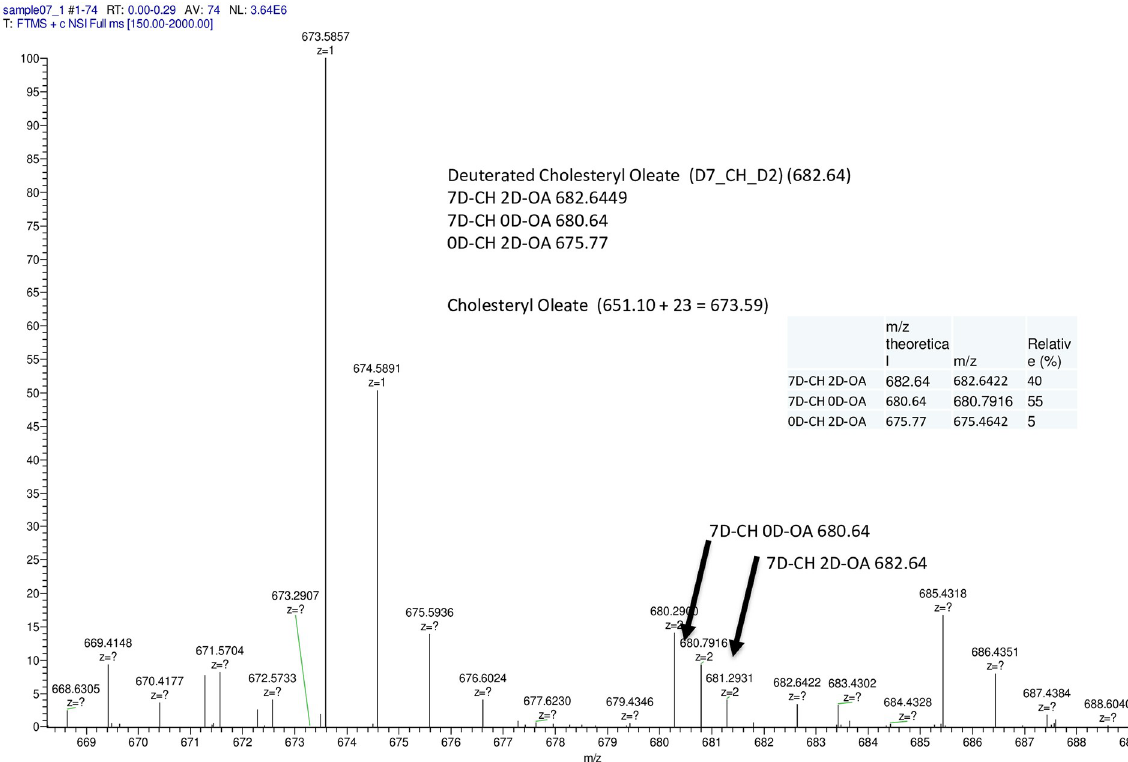
Fig 10. Direct transport of CE as evaluated by ESI-QTOF-MS in SR-BI expressing HeLa cells. The cells were loaded with 200 μ g/ml of D9-CE (TO) LDL for 6 hours collected and used for LD isolation. LD lipids were subjected to TLC using banding of the principal neutral lipids isolated and analyzed using ESI-QTOF-MS as described in Materials and Methods. The Insert table describes the three deuterated-CE forms, their spectra and percentiles.